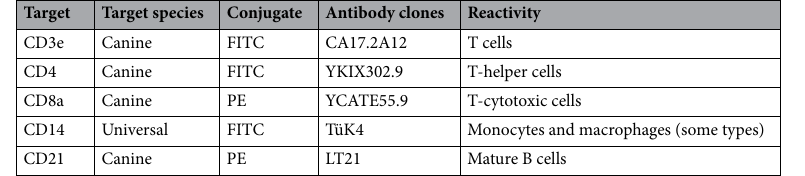
Table 2. Antibodies were used in the characterization of different PMBC subsets in